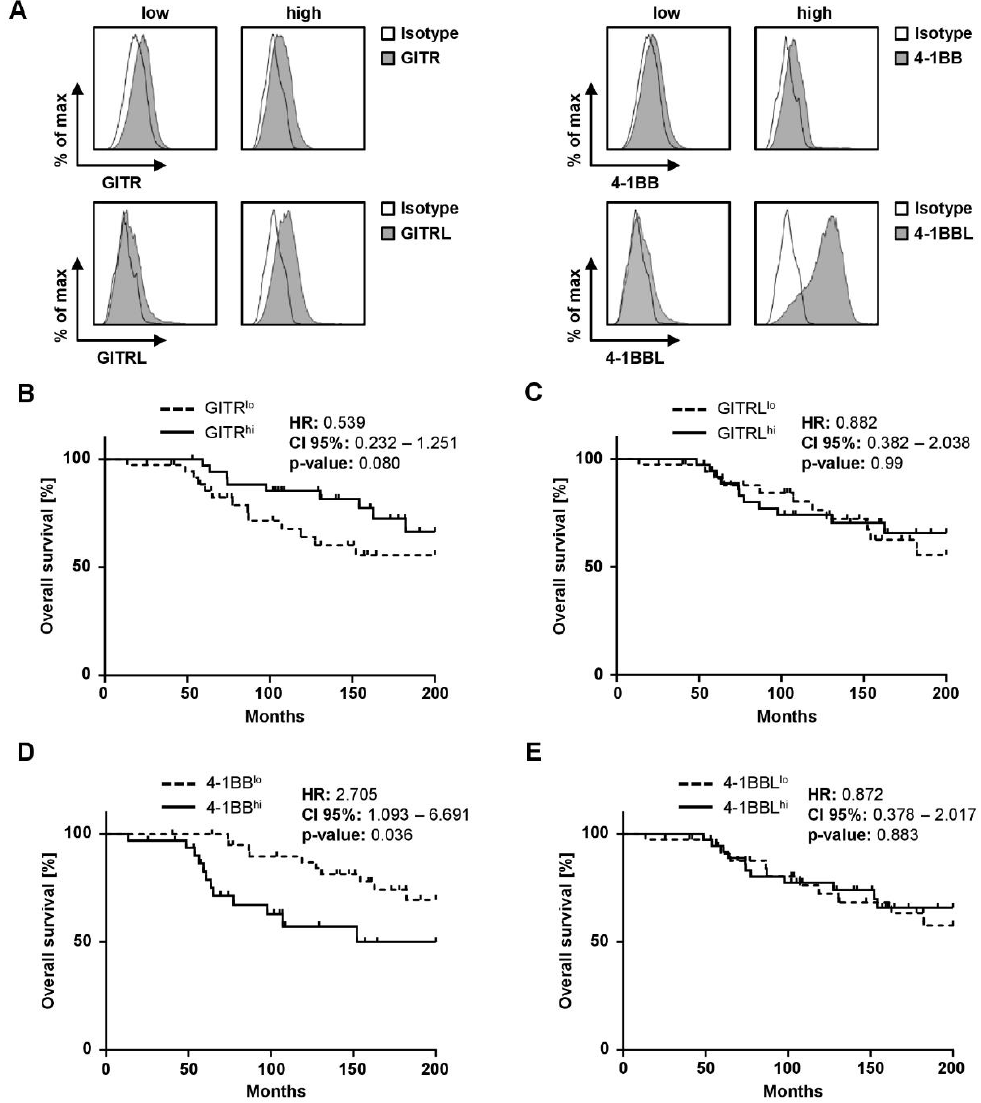
Figure 4. Impact of GITR, GITRL, 4-1BB, or 4-1BBL expression on CLL patients’ survival. ( A ) Exemplary histogram plots for each surface marker of high and low expressing patients are shown by flow cytometry. ( B – E ) Overall survival of CLL patients according to GITR lo and GITR hi , GITRL lo and GITRL hi , 4-1BB lo and 4-1BB hi , and 4-1BBL lo and 4-1BBL hi expression (SFI) in Kaplan-Meier analysis. Low and high GITR/GITRL/4-1BB/4-1BBL expression levels are sub-grouped according to median of SFI levels of surface markers. Median OS for GITR hi (continuous line) and GITR lo cases (dotted line) was not reached (log-rank test). Median OS was reached in GITRL hi (continuous line) and GITRL lo (dotted line) was not reached (log-rank test). In 41BB hi the median OS was 152 month (continuous line) and was not be reached in 4-1BB lo (dotted line) and differed significantly (log-rank test). Median OS in 4-1BBL hi and 4 1BBL lo was not reached (dotted line; log-rank